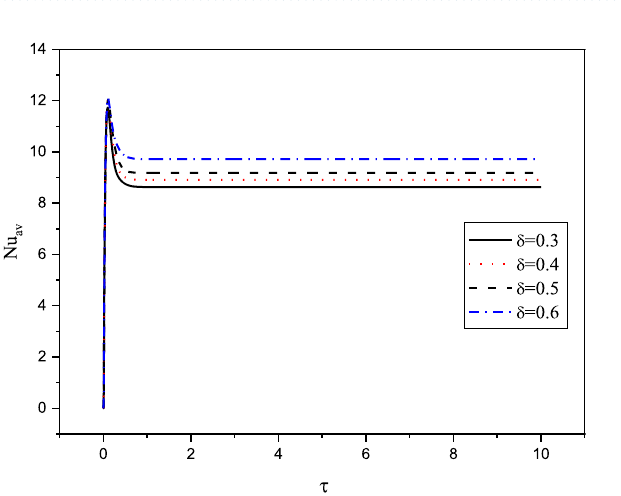
3 , Ra 10 10 6 , δ 0.4, Ha − = = =